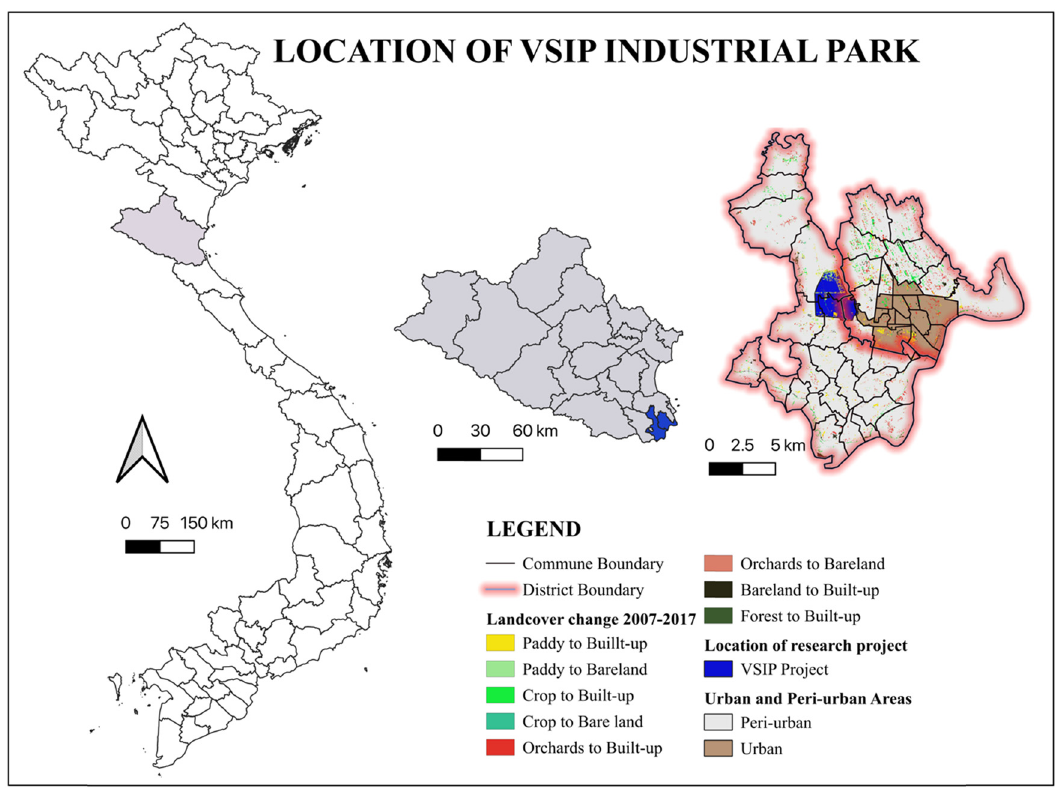
Figure 3: The location of VSIP Nghe An industrial park.